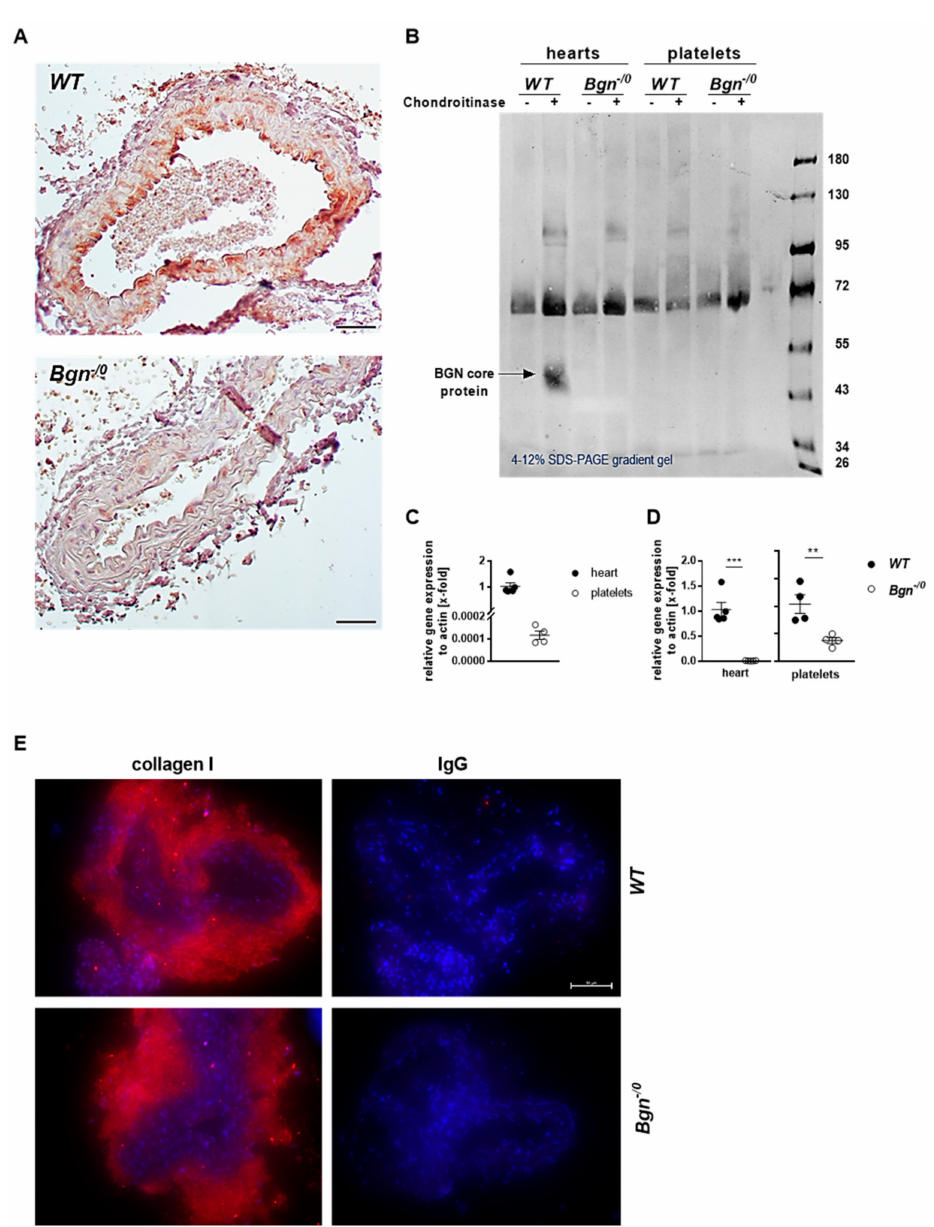
Figure 1. Minor expression of biglycan in platelets. ( A ) Representative images of biglycan in the ECM of the carotid artery. Biglycan was stained in paraffin-embedded sections of the carotid artery of wildtype (upper panel) and Bgn -/0 mice (lower panel) after FeCl 3 -induced injury to confirm the presence of biglycan in the subendothelial layer of the vessel. Biglycan was not present in the vessel wall of biglycan-deficient mice. Nuclei were stained with Mayers hemalum. Scale bar = 100 µ m. ( B ) Western blot analysis of biglycan in murine hearts and platelets from wildtype and biglycan- deficient mice. ( C ) Detection of biglycan mRNA in platelets from WT mice using qRT-PCR. mRNA isolated from murine hearts was used as a positive control. Mean values ± SEM, n = 4–5. ( D ) Biglycan expression in platelets and heart tissue from Bgn -/0 mice compared to WT mice using qRT-PCR. Mean values ± SEM, n = 4–5. ( E ) Collagen I distribution (red) in the carotid artery is not altered in biglycan- deficient mice compared to wildtype controls, cell nuclei stained with DAPI (blue), n = 3. Statistical analysis was performed with two-tailed paired Student’s t -test, ** p < 0.01, *** p <